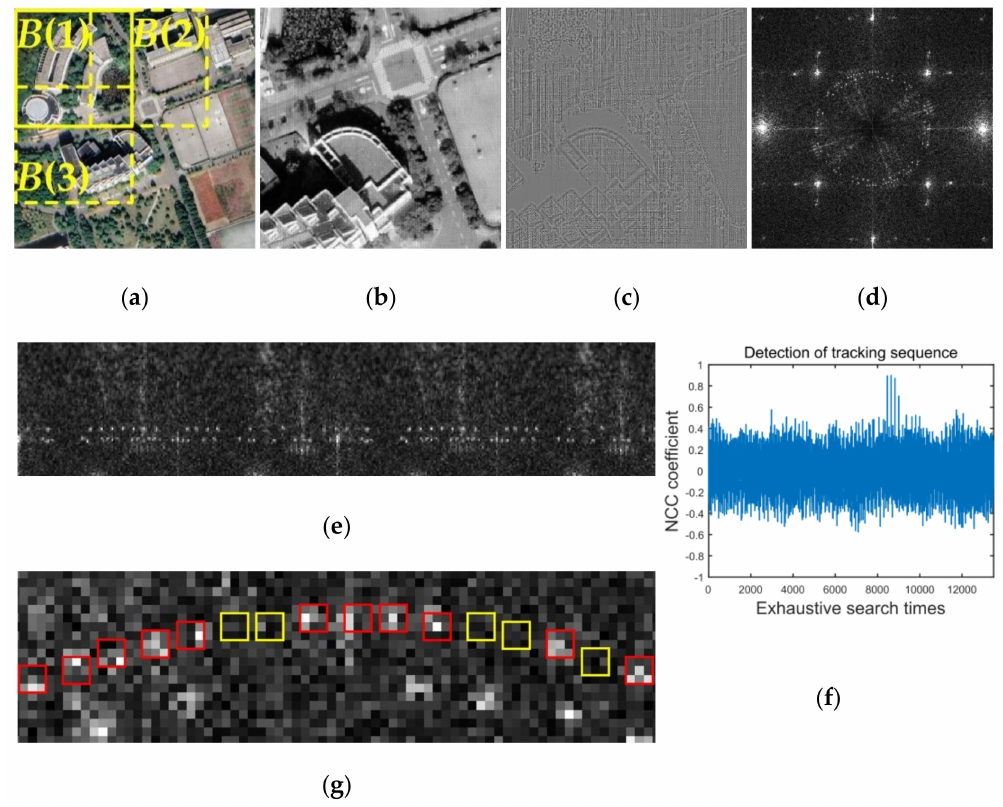
Figure 11. Detection and extraction process of watermark A. ( a ) Examples of blocks can be used for watermark detection; ( b ) luminance spectrum of one block; ( c ) noise component of one block; ( d ) DFT domain of noise component; ( e ) map detection range from Cartesian coordinates to polar coordinates; ( f ) calculate NCC coefficients; ( g ) 3 × 3 region centered at embedding